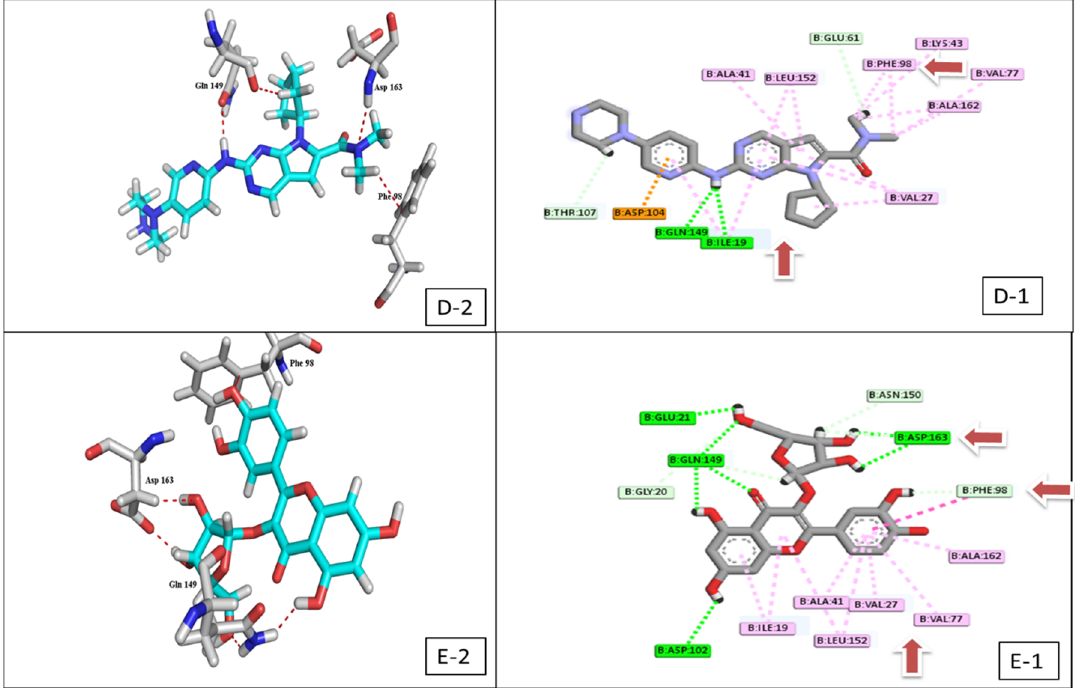
Figure 4. 2D & 3D interaction of the top docking pose of ribociclib ( D-1 , D-2 ) and compound 10 ( E- 1 , E-2 ) at the active domain of CDK-6 enzyme.